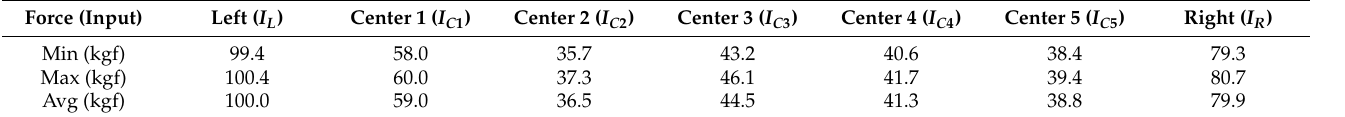
Figure 12. Optimal pressing for uniformity using multi regression analysis: ( a ) Output value with uniform pressing force ( 2 kgf ± 5%) ; ( b ) Input value optimization result of input pushing force. Table 2. Optimized load value of Figure 11b.